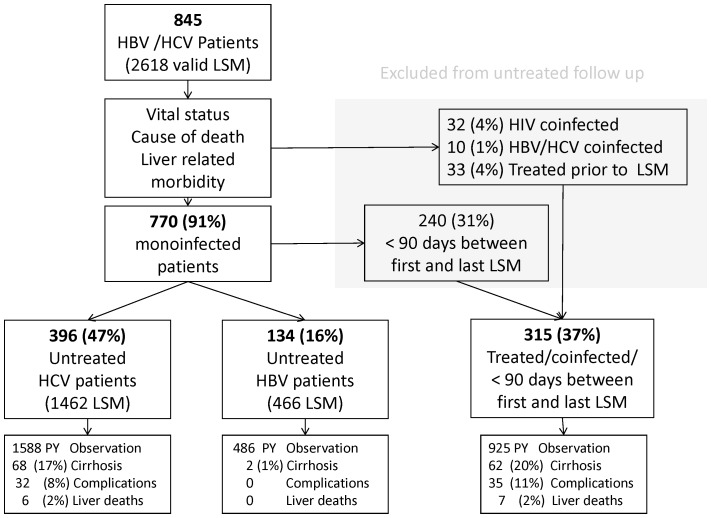
Flow chart of patients showing follow-up liver stiffness measurements.